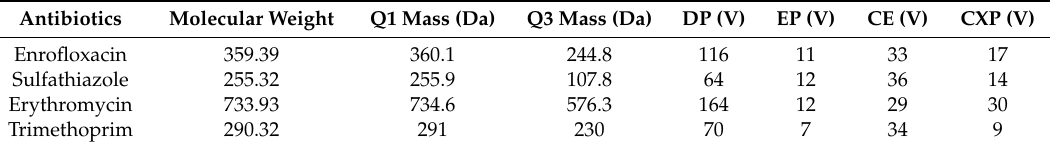
Table 3. Optimum conditions for MS / MS (ESI positive mode) analysis of antibiotics (DP: declustering potential; EP: entrance potential; CE: collision energy; CXP: collision cell exit potential. V: Volts. Da: